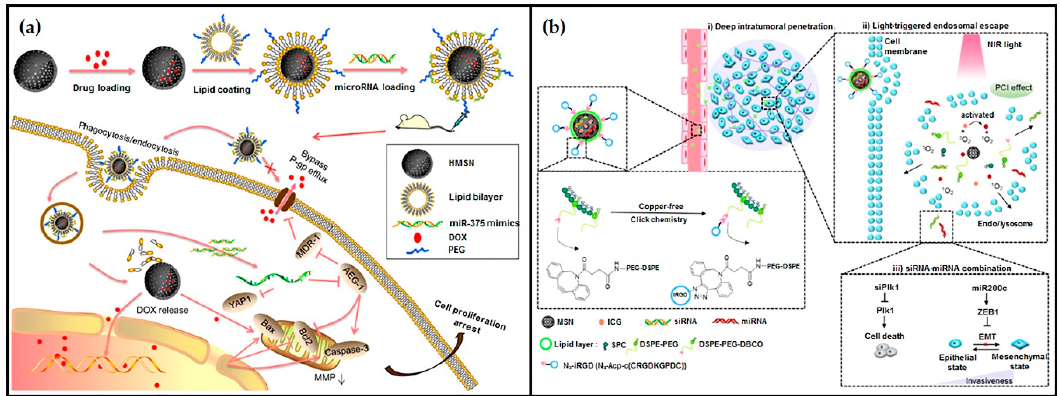
Figure 16. Schematic illustrations of recently reported combination therapies using lipid-coated silica nanoparticles: ( a ) Development and antitumor mechanism of LHD/miR-375 (reproduced from [102], with permission from Dove Medical Press Limited); ( b ) iRGD-modified lipid-coated MSNs and light-triggered siPlk1/miR-200c delivery mechanism (reproduced with permission from [103], copyright 2020, American Chemical Society).